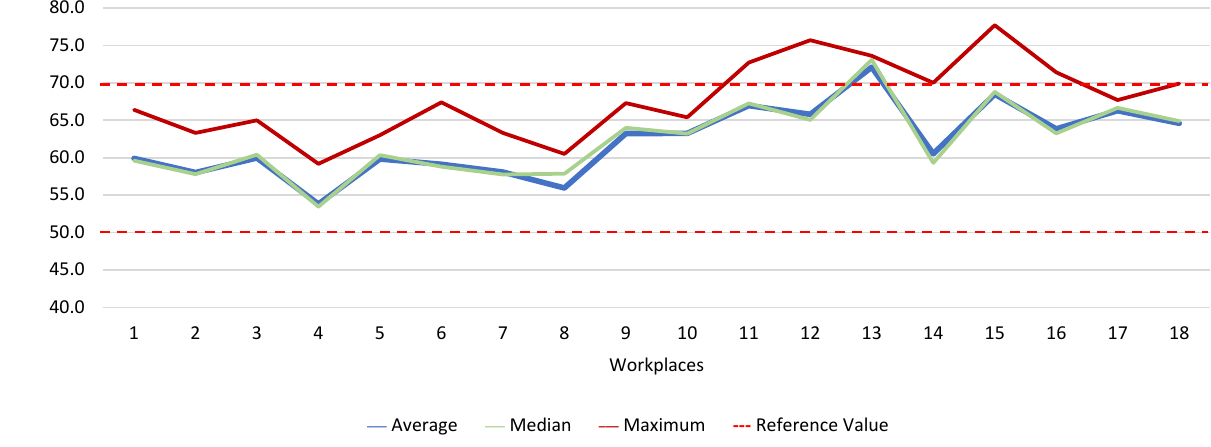
Figure 18. Relative humidity values (%) inside workplaces.